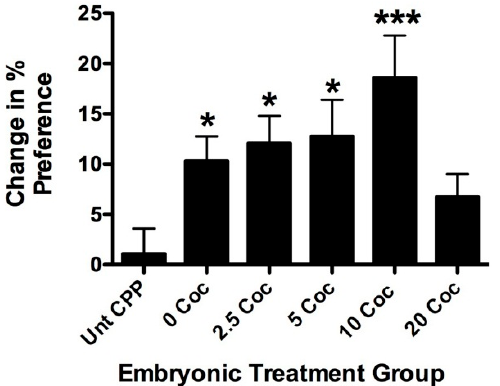
Figure 5. Pre-exposure to cocaine in larval fish affects cocaine-induced conditioned place preference (CPP) in longitudinal adults. This histogram represents data from four experiments combined testing CPP in longitudinal adults raised from larvae exposed to different doses of cocaine. Fish from all embryonic treatment groups not treated with cocaine as adults were combined into a single group for comparative purposes (Unt CPP). CPP was tested using 5 mg/L for all embryonic treatment groups and is expressed as a change in the percentage of time spent in the conditioning chamber before and after drug exposure. Cocaine pre-exposure during development results in a bell-shaped response curve for CPP in longitudinal adults. All longitudinal groups showed significantly higher CPP than untreated controls except for fish previously exposed to 20 mg/L cocaine. The maximal response observed in fish previously exposed to 10 mg/L and this group had the lowest p -value and was also significantly higher than the 20 mg/L group ( p < 0.05). (Error bars represent ± SEM, * indicates p < 0.05, *** indicates p < 0.001 when compared to the untreated control group, n = 33 for untreated controls, n = 44 for 0 mg/L cocaine, n = 22 for 2.5 mg/L, n = 22 for 5 mg/L, n =30 for 10 mg/L, and n = 37 for 20 mg/L).